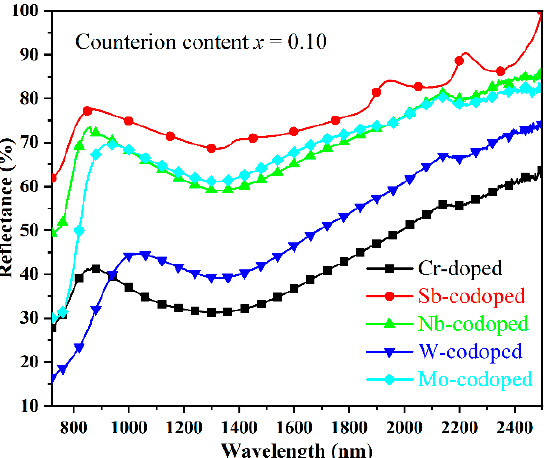
Figure 5. NIR reflectance spectra of the Cr-doped TiO 2 pigments with and without counterions.